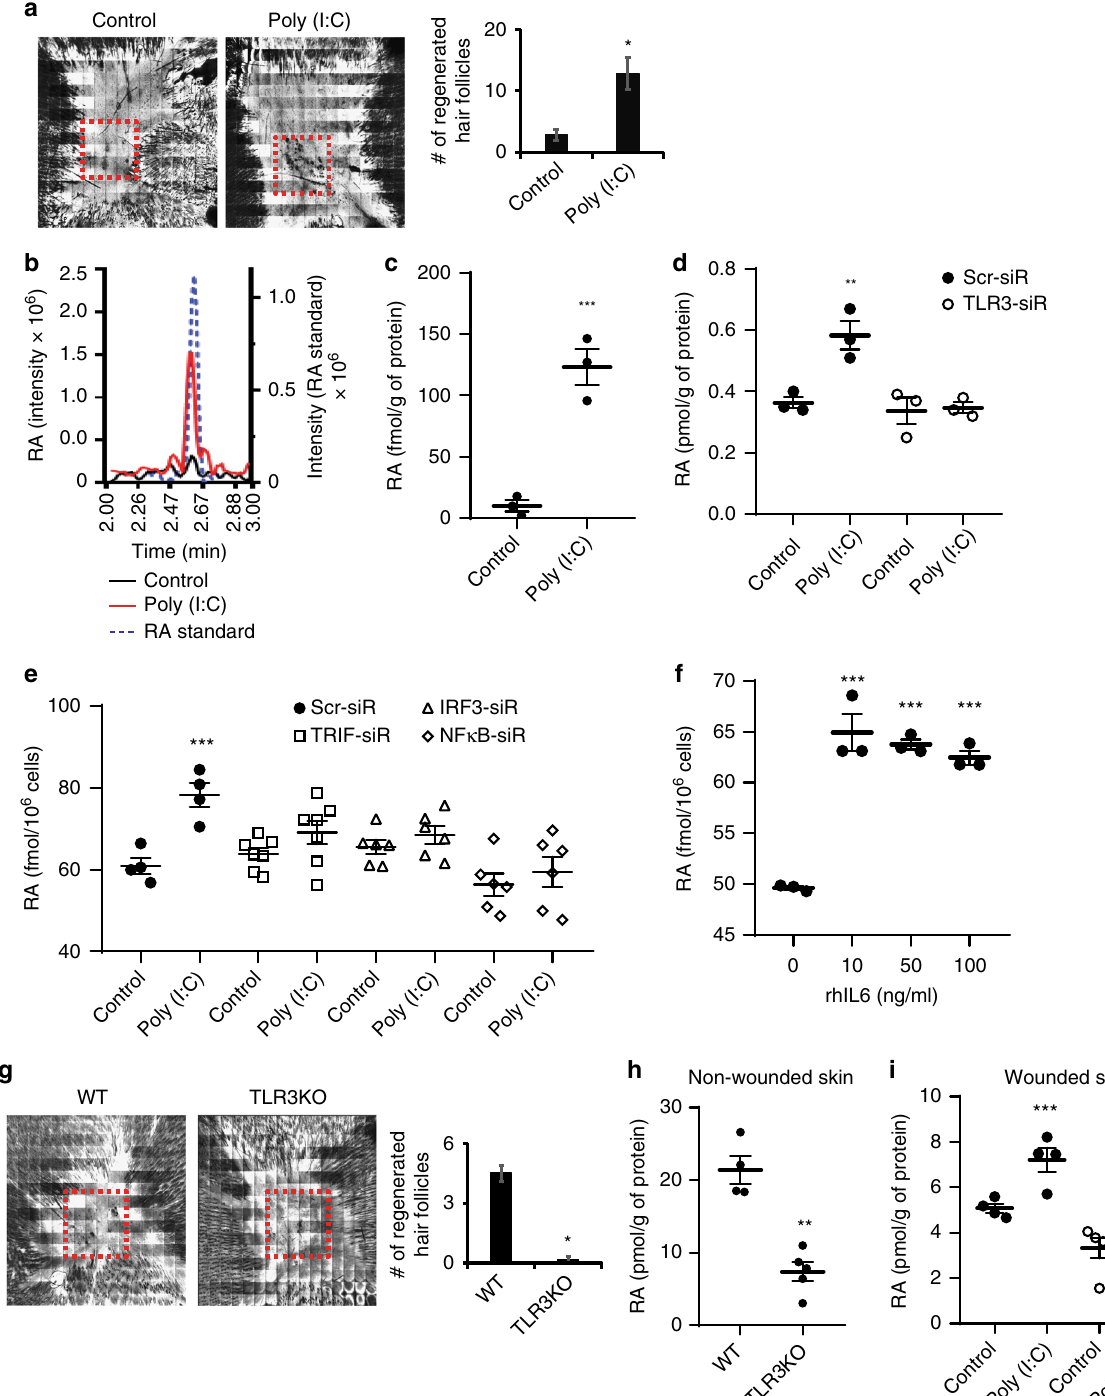
Fig. 2 dsRNA and TLR3 are suf fi cient and necessary to stimulate RA accumulation. a A single injection of Poly (I:C) (50 µ l; 5 µ g per mouse) induces wound- induced hair neogenesis (WIHN) as seen by Confocal scanning laser microscopy (CLSM) images and quanti fi ed averages. Red dashed lines indicate area of WIHN ( n = 5 independent animals, ** P < 0.01, unpaired Student t -test). b, c In LC-MS/MS analysis, Poly (I:C) (0.5 µ g per ml) increases RA levels in cell pellet lysates of human scalp keratinocytes) compared to an RA standard (b), and is substantial across replicates (c, n = 3 independent experiments, *** P < 0.001, paired Student t -test). d Poly (I:C) (0.5 µ g per ml)-mediated RA synthesis is dependent on TLR3 ( n = 3 independent experiments, ** P < 0.01,